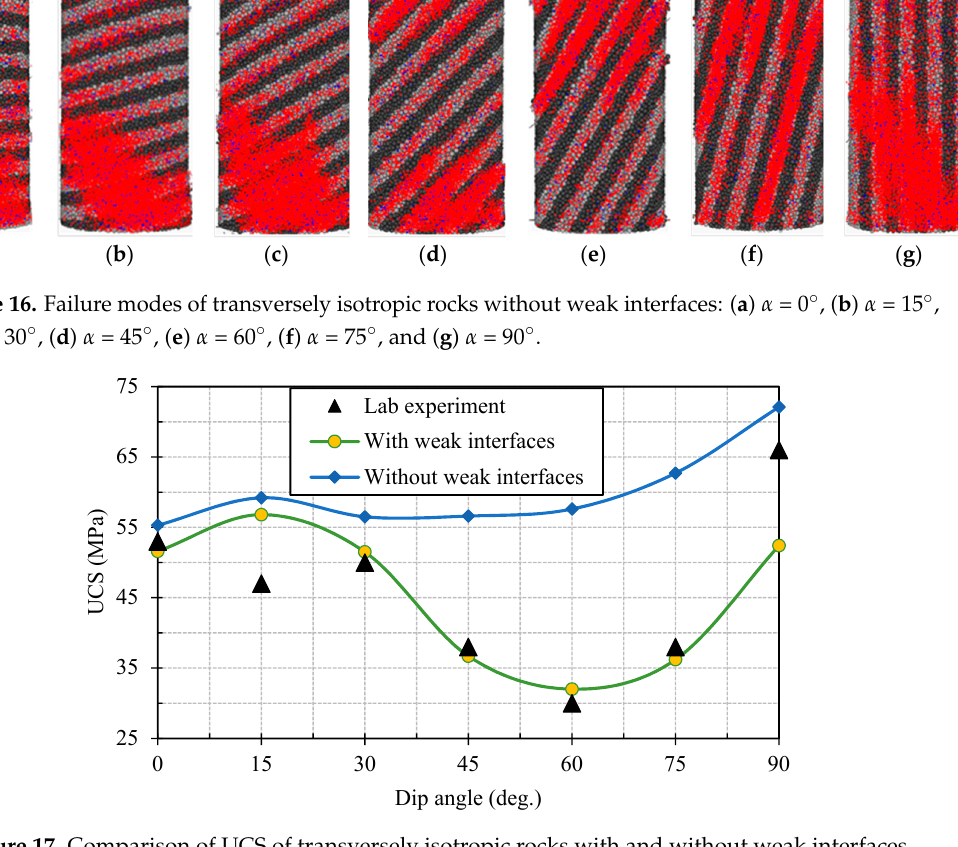
Figure 17. Comparison of UCS of transversely isotropic rocks with and without weak interfaces.